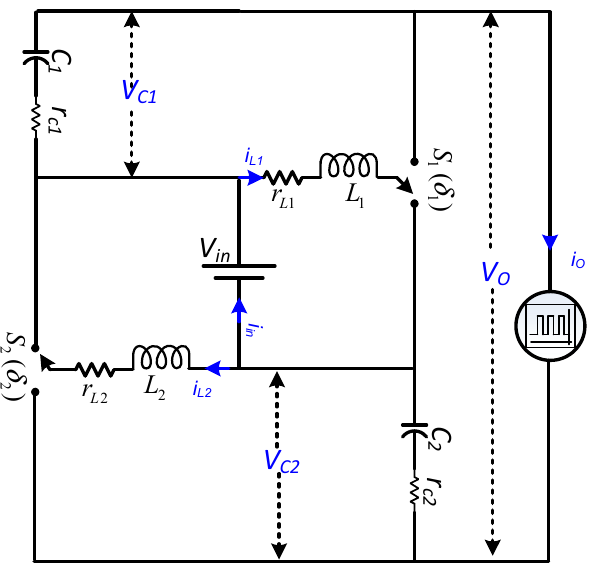
Figure 3. Interleaved capacitor clamped boost converter.